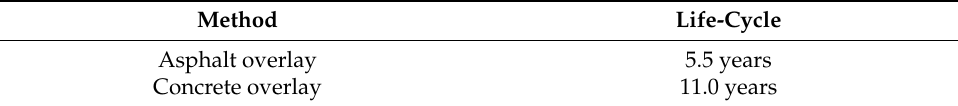
Table 3. Overlay life-cycle.